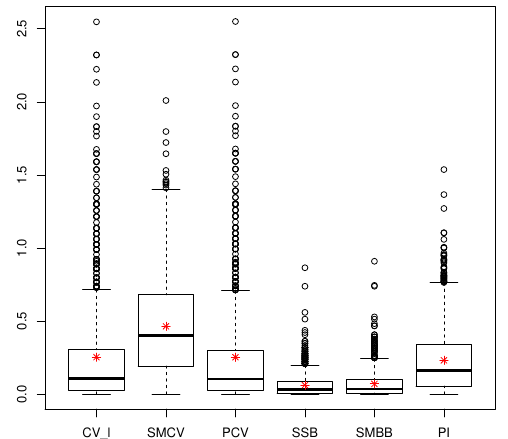
(cid:16) (cid:17) MISE ( ˆ h ) / MISE ( h MISE ) , n = 100, where ˆ h = h CV (fourth box), h ∗ (fifth box) and h PI (sixth SSB SMBB